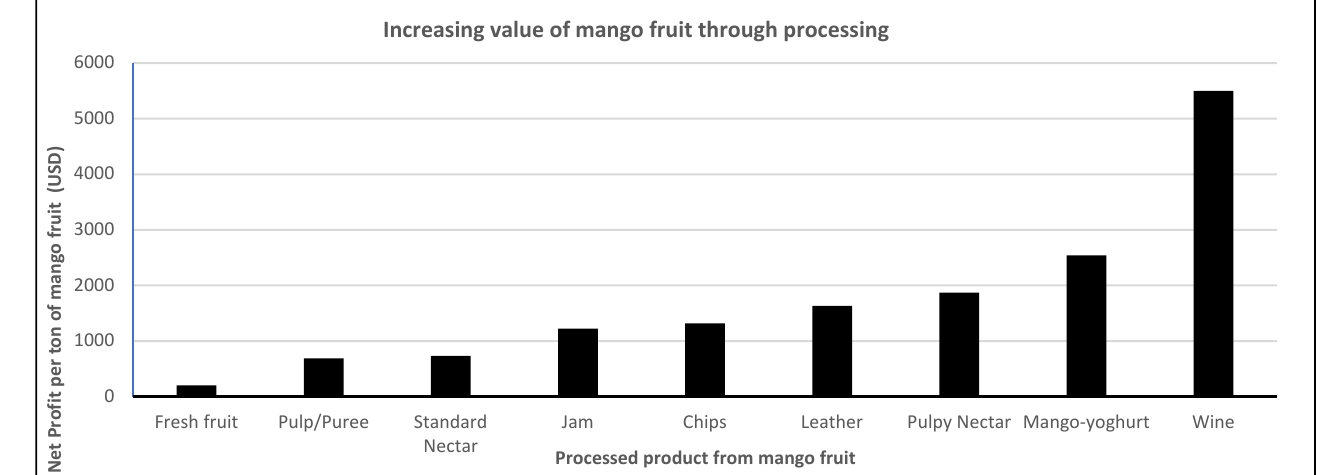
Figure 3. Net profits (USD) derived from processing 1 ton of mango fruit into various products [77]